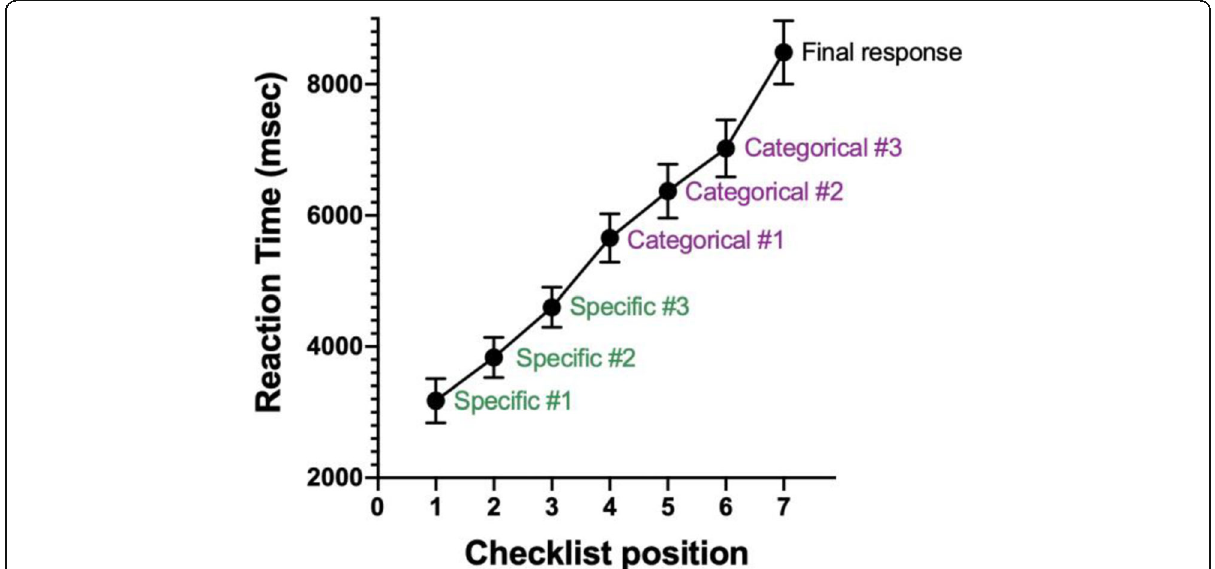
Fig. 9 Average reaction times (RTs) for each of the 7 responses in Experiment 3. Error bars are ± 1